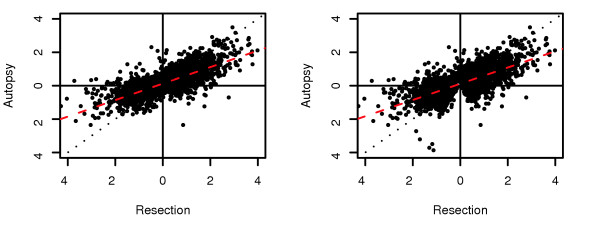
Scatter plot of expression differences between cortex and hippocampus in resection (x-axis) and autopsy (y-axis) samples. Expression differences were calculated as base two logarithm transformed ratios of gene expression values. All probe sets showing significant differences in expression levels between the two brain regions, either in the autopsy or in resection samples, are plotted: (a) according to Student's t test; (b) according to SAM. Red dashed lines represent linear regression results and black dotted lines represent expected regression lines with the slope = 1.